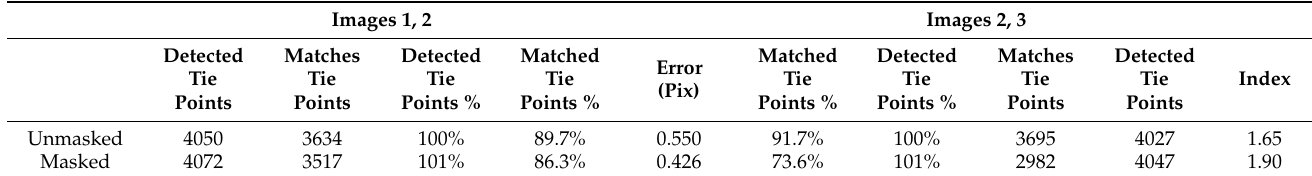
Figure 19. Detected features on the images defined by the software and matched features (Blue points) in both unmasked ( a ) and masked ( b ) images. Table 5. Effect of masking background on detecting and matching features (tie